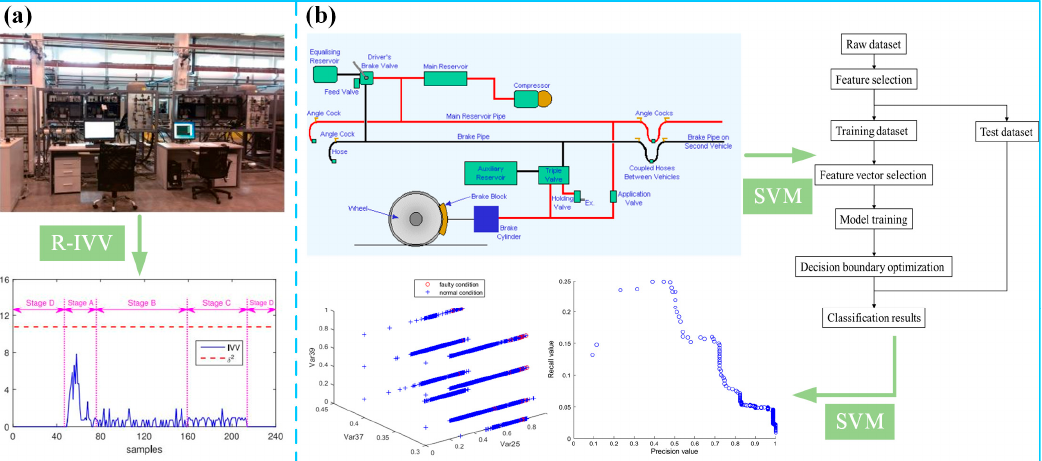
Figure 8. Fault diagnosis method of brake system: ( a ) refined inter-variate variance (R-IVV) [82]; ( b ) support vector machine (SVM) [83].